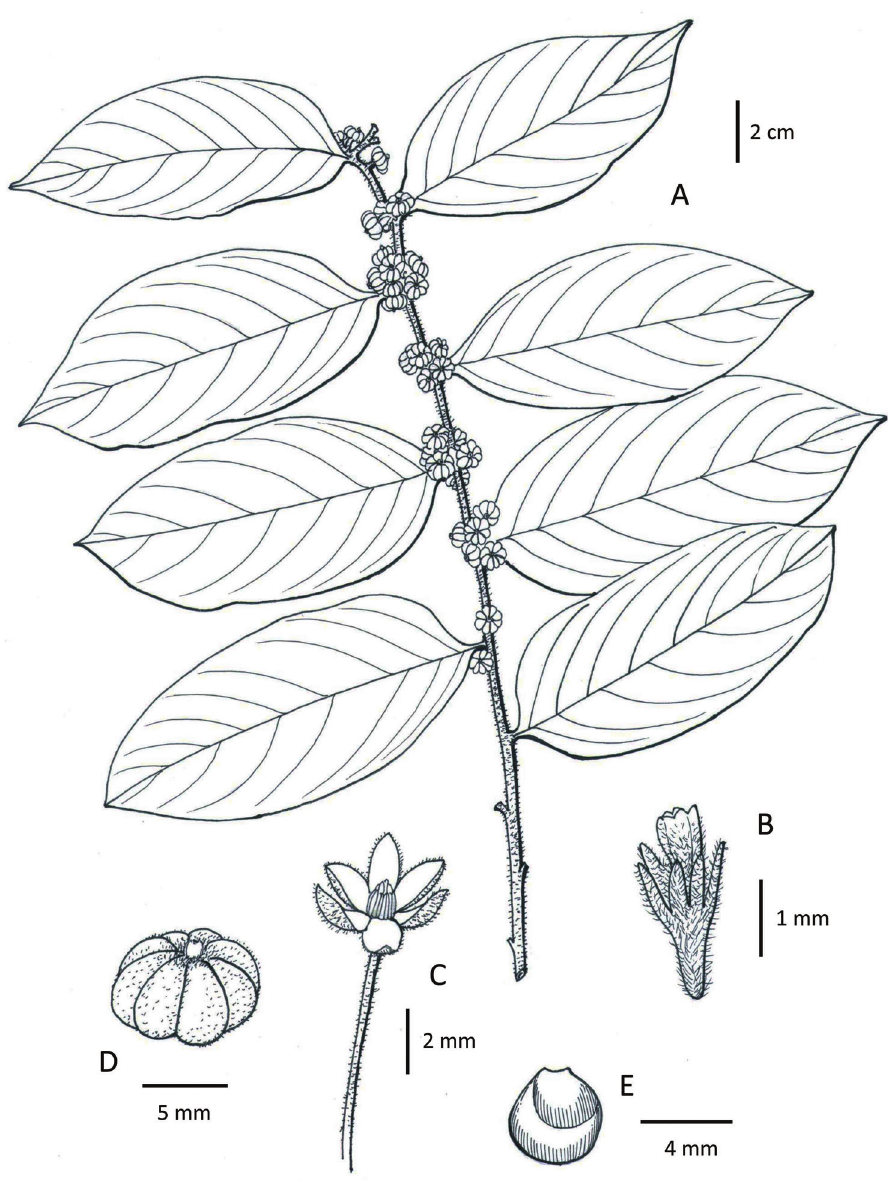
Figure 1. Line drawing of Glochidion shanense Gang Yao & Shixiao Luo, sp. nov. A Habit B Female flower C Male flower D Fruit E Seed. Draw by Ling Wang on Jie Cai et al. 15CS10794